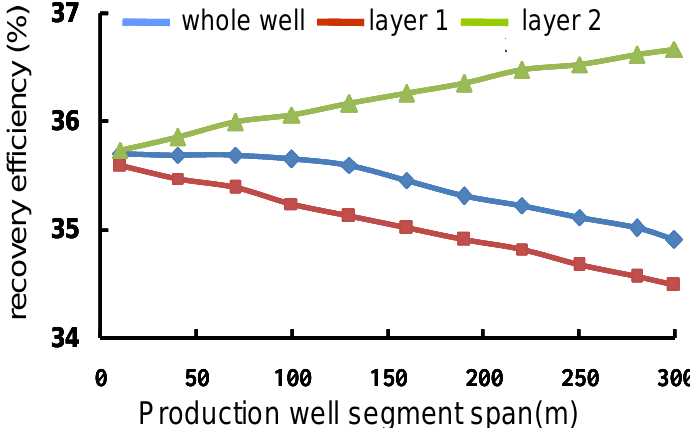
Figure 5—Relation curve between recovery efficiency and production well